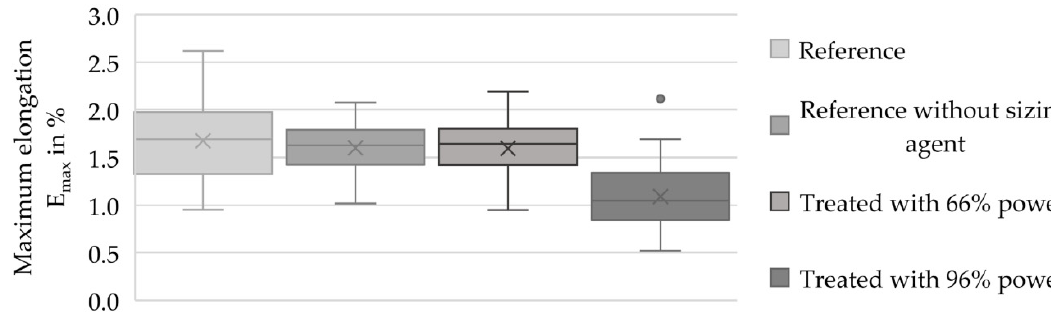
Figure 7. Boxplot diagram with the maximum elongation results (E max in %) of the filament references and the treated and detached filaments.